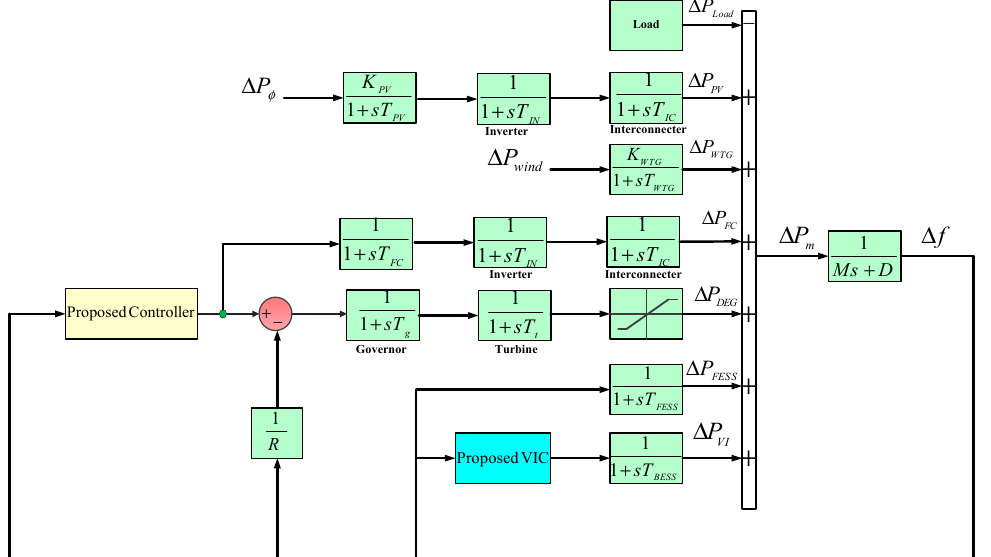
Figure 2. Transfer function model of the islanded MG.